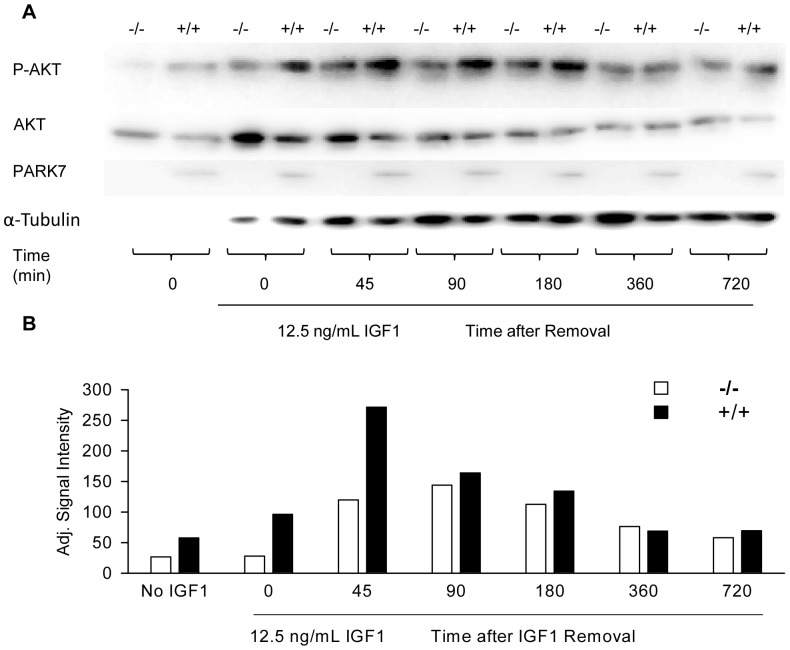
Sustained activity of AKT phosphorylation (S473) in Park7 (+/+) and Park7 (−/−) myotubes after IGF1 stimulation.Mature myotubes were stimulated with IGF1 (12.5 ng/mL) for 15 minutes. Total protein was extracted at the indicated time after removal of IGF1. A: Western blot analysis showed a higher level of AKT phosphorylation in Park7 (+/+) relative to Park7 (−/−) myotubes. PARK7 blotting confirmed the cell genotypes and α-tubulin blotting was used as a loading control. B: Analysis of the signal intensity for P-AKT/total AKT ratio (adj. signal intensity) showed the Park7 (+/+) myotubes had higher AKT phosphorylation without added IGF1 and had a 3 fold higher level of P-AKT/total AKT than Park7 (−/−) myotubes at 45 minutes after IGF1 treatment. The decline in AKT phosphorylation was similar between the genotypes after 90 minutes with Park7 (+/+) myotubes generally maintaining approximately 20% higher signal intensity. This experimental design was replicated twice on individual blots with similar results. The signal intensity data was derived from the blot shown in A.